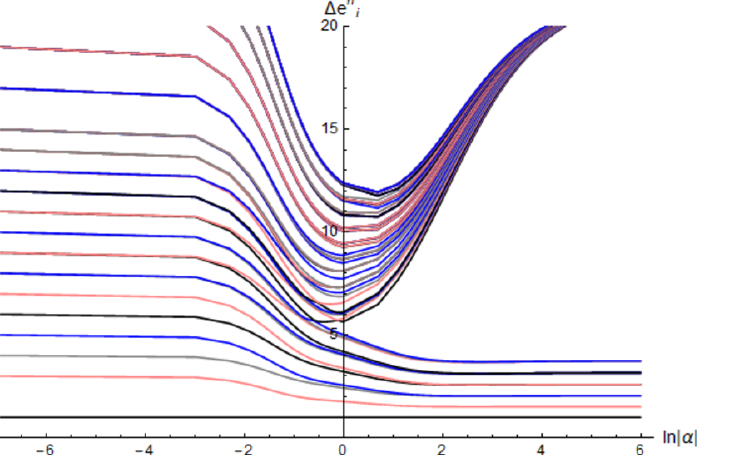
Figure 20. (cid:1) e n against ln j (cid:11) j for free spectator, positive coupling and N 1 i is half integer. We test this pattern further using generalised truncation schemes (1.5)